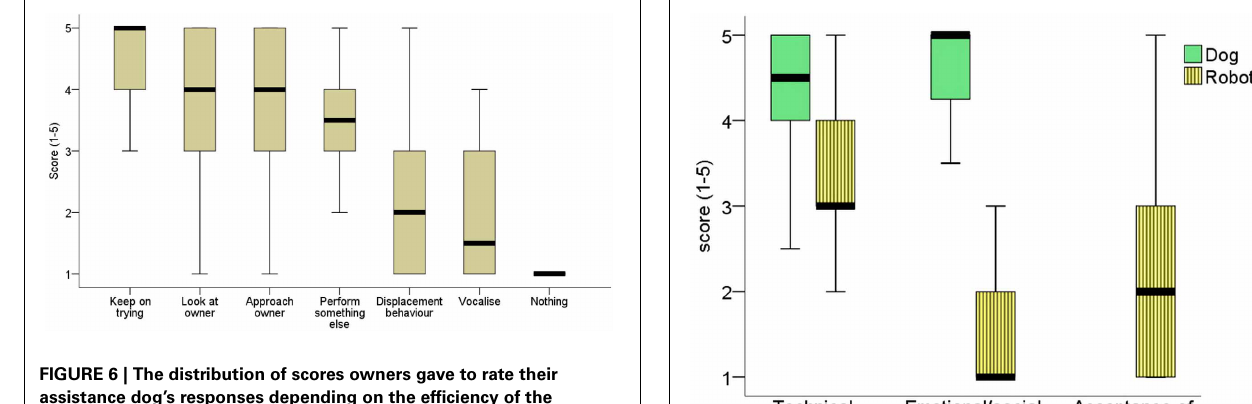
FIGURE 6 | The distribution of scores owners gave to rate their assistance dog’s responses depending on the efficiency of the behavior in attenuating their annoyance/disappointment in situations when the dog cannot/does not perform a task (No 7). The heavy black lines mark the median (50th percentile), the boxes mark the lower and upper quartiles, and the whiskers mark the minimum and maximum observed values that are not statistically outlying.